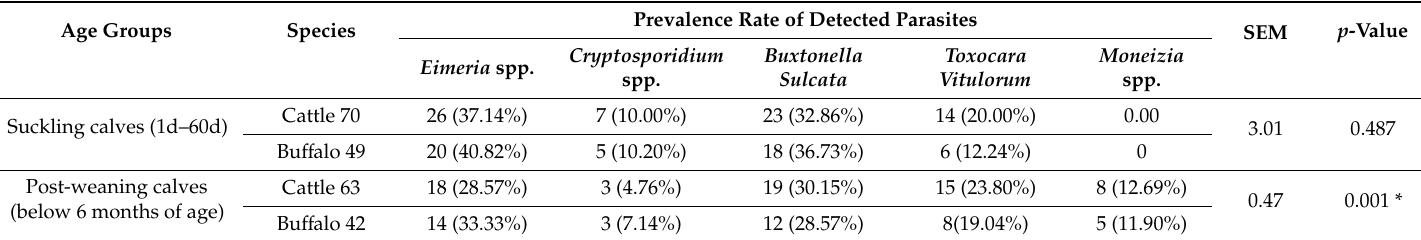
Table 2. Prevalence rate of intestinal parasites causing diarrhea in cattle and bu ff alo calves.